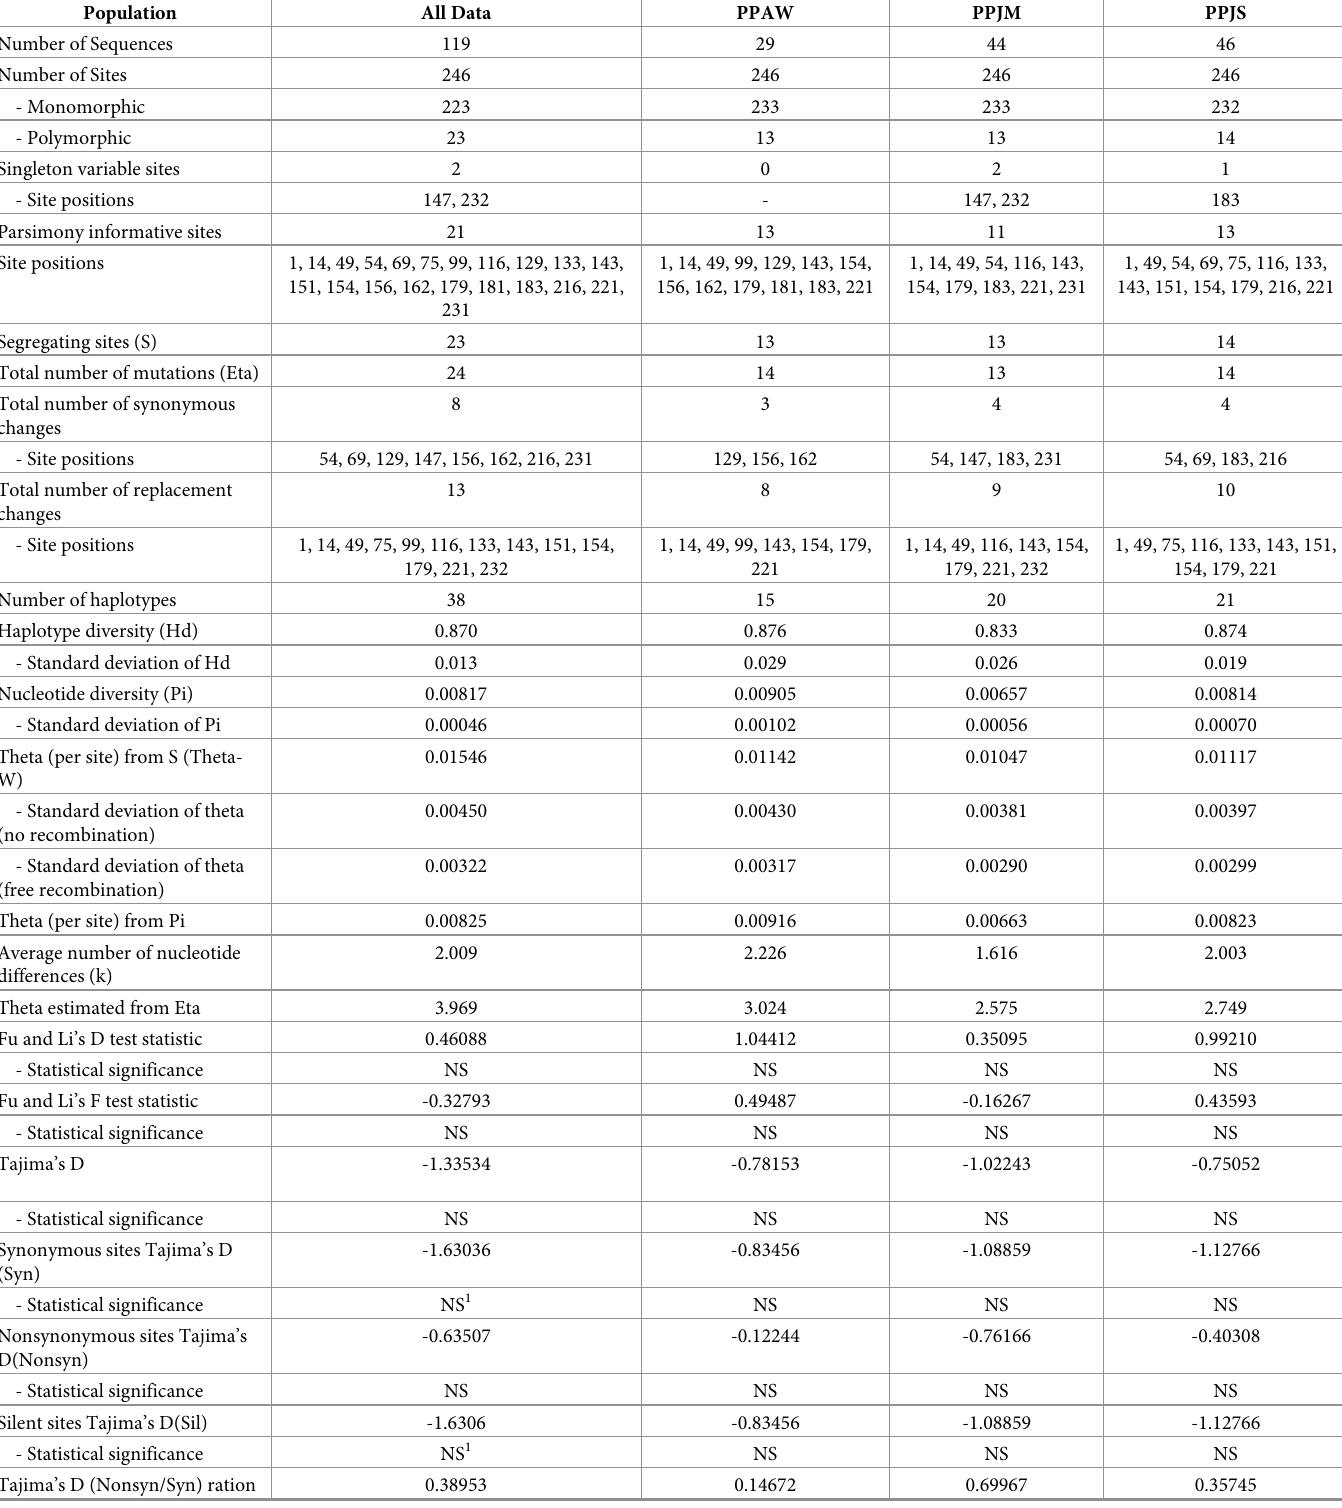
Table 5. PpSP14 population genetics analyses for P . papatasi